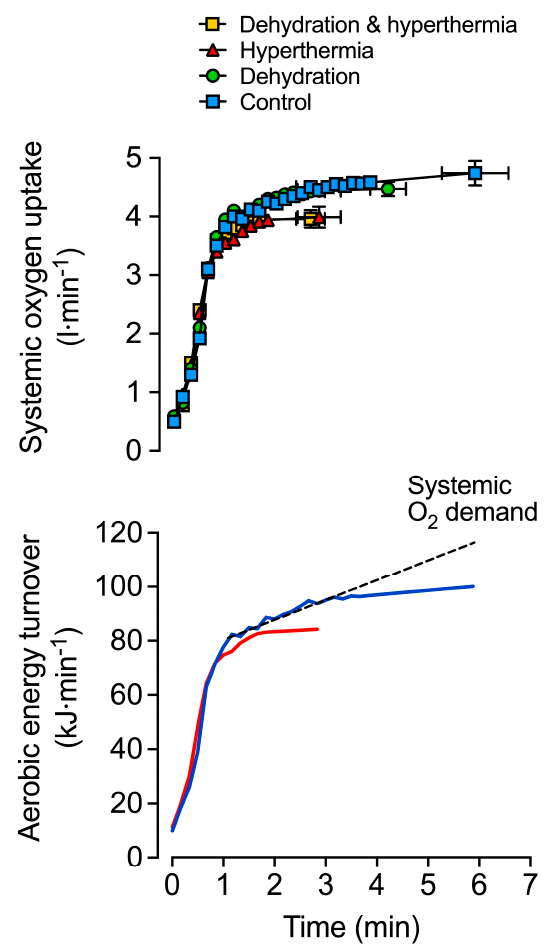
Figure 3. Impact of dehydration and hyperthermia on maximal oxygen uptake and aerobic energy turnover. Oxygen consumption dynamics were measured during constant load maximal cycling (402 ± 4 W) under control, dehydration (4% body weight loss without hyperthermia), hyperthermia (+1 ◦ C and +6 ◦ C increase in T c and skin temperature, respectively) and combined dehydration and hyperthermia. Note that both combined dehydration and hyperthermia and hyperthermia alone impaired V O 2max and exercise performance by 16% and 51–53% compared to control, without altering the initial absolute V O 2 responses. Preventing hyperthermia in dehydrated individuals restored V O 2max and exercise performance by 65% and 50%, respectively. These data demonstrate that aerobic metabolism and maximal endurance capacity can be drastically compromised in the dehydrated and hyperthermic human. The dotted line is the theoretical systemic O 2 demand. Redrawn from data (means ± SE) reported by Nybo et al.